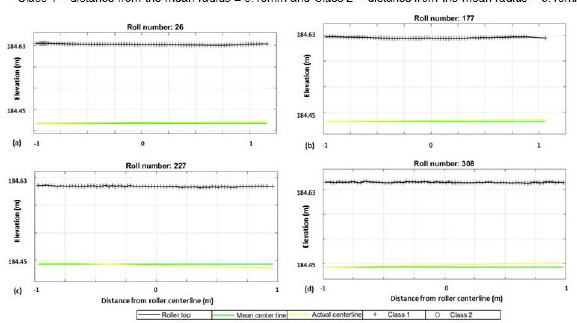
Figure 15. Mean and actual roller axis and the surface